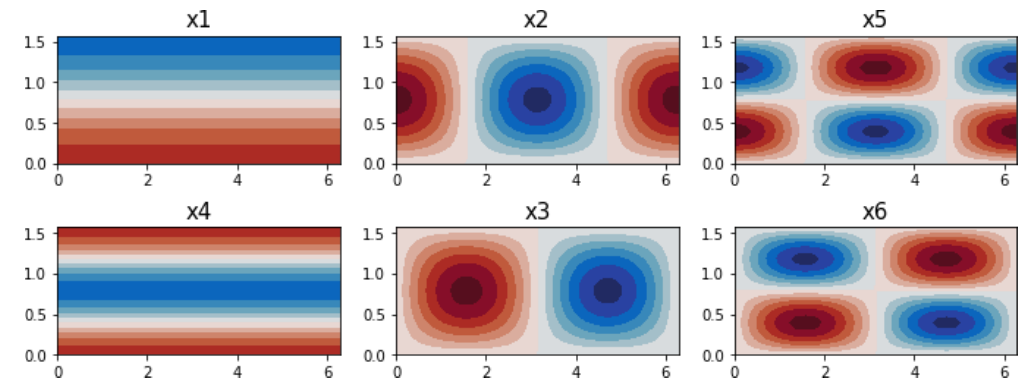
Figure A1. The real-valued basis functions used in the spectrally truncated CdV79 system, plotted as streamfunctions.